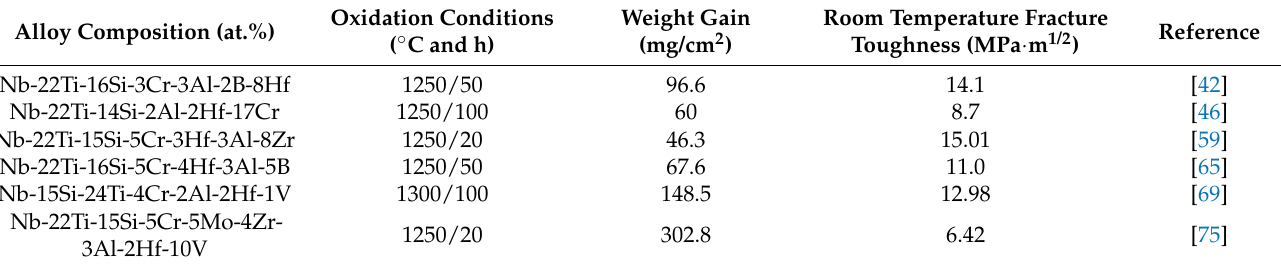
Table 2. Comparison between different